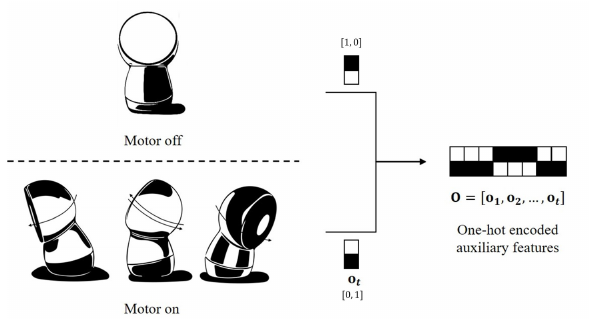
Figure 3. Extracting auxiliary features from the motor on/off state information for every frame (“Motor off” state with fan noise only and “Motor on” state with additional movement